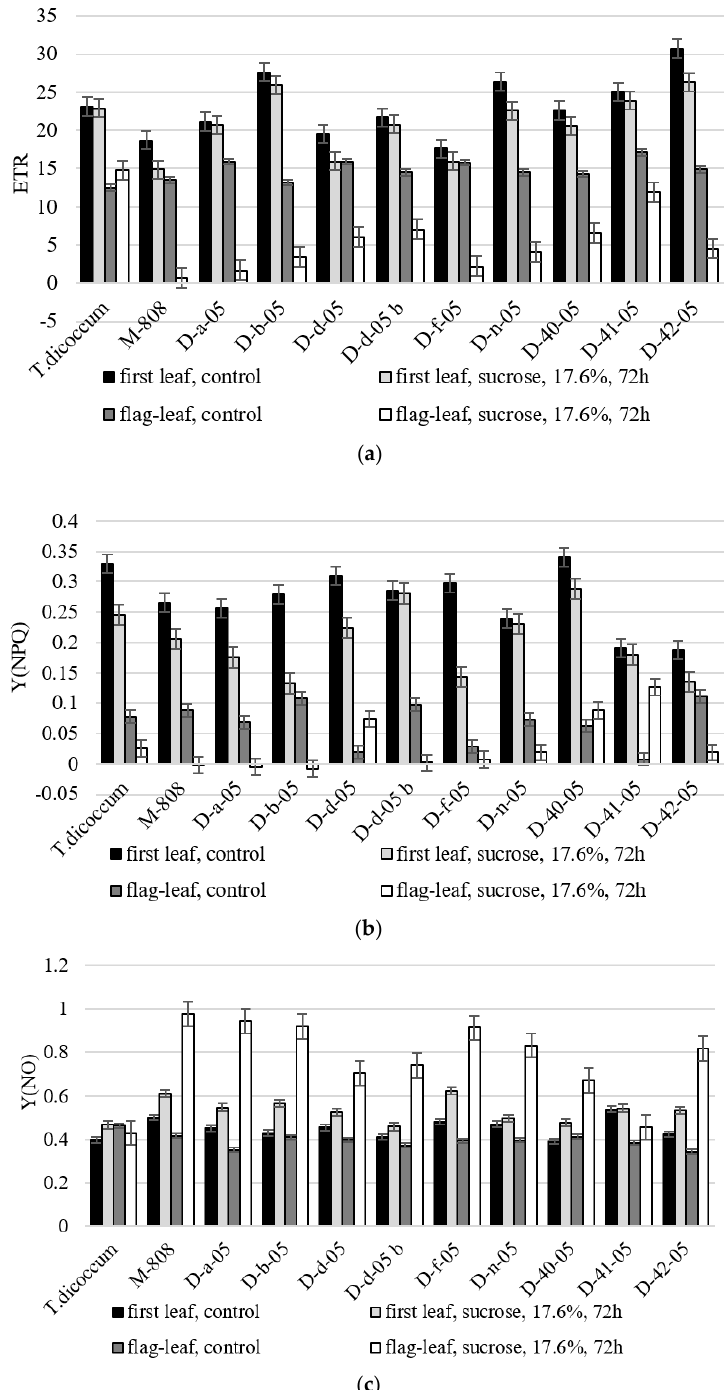
Figure 6. Mean of photosynthetic parameters electron transport rate (ETR) (a), Y(NPQ) (b), Y(NO) (c) (relative units) of alloplasmic lines under optimal and drought conditions (17.6% sucrose, 72 h). Values presented are means (± SD).